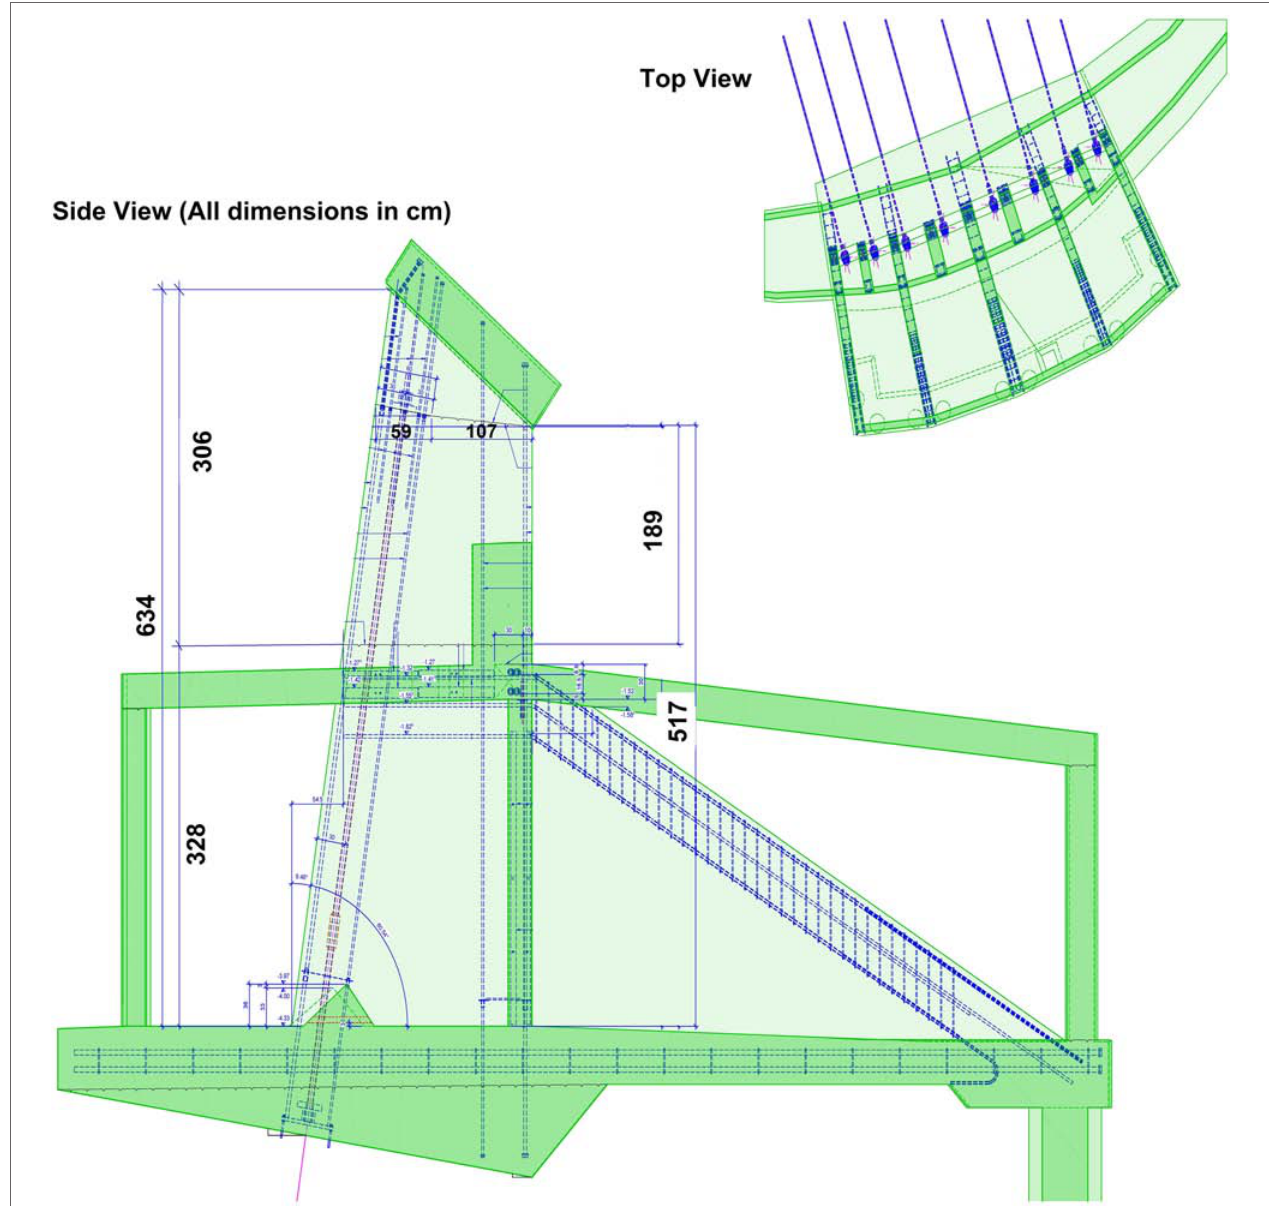
FIGURE 2 | Top: plan view of a pillar group; left: cross-section and reinforcement drawing for a pillar